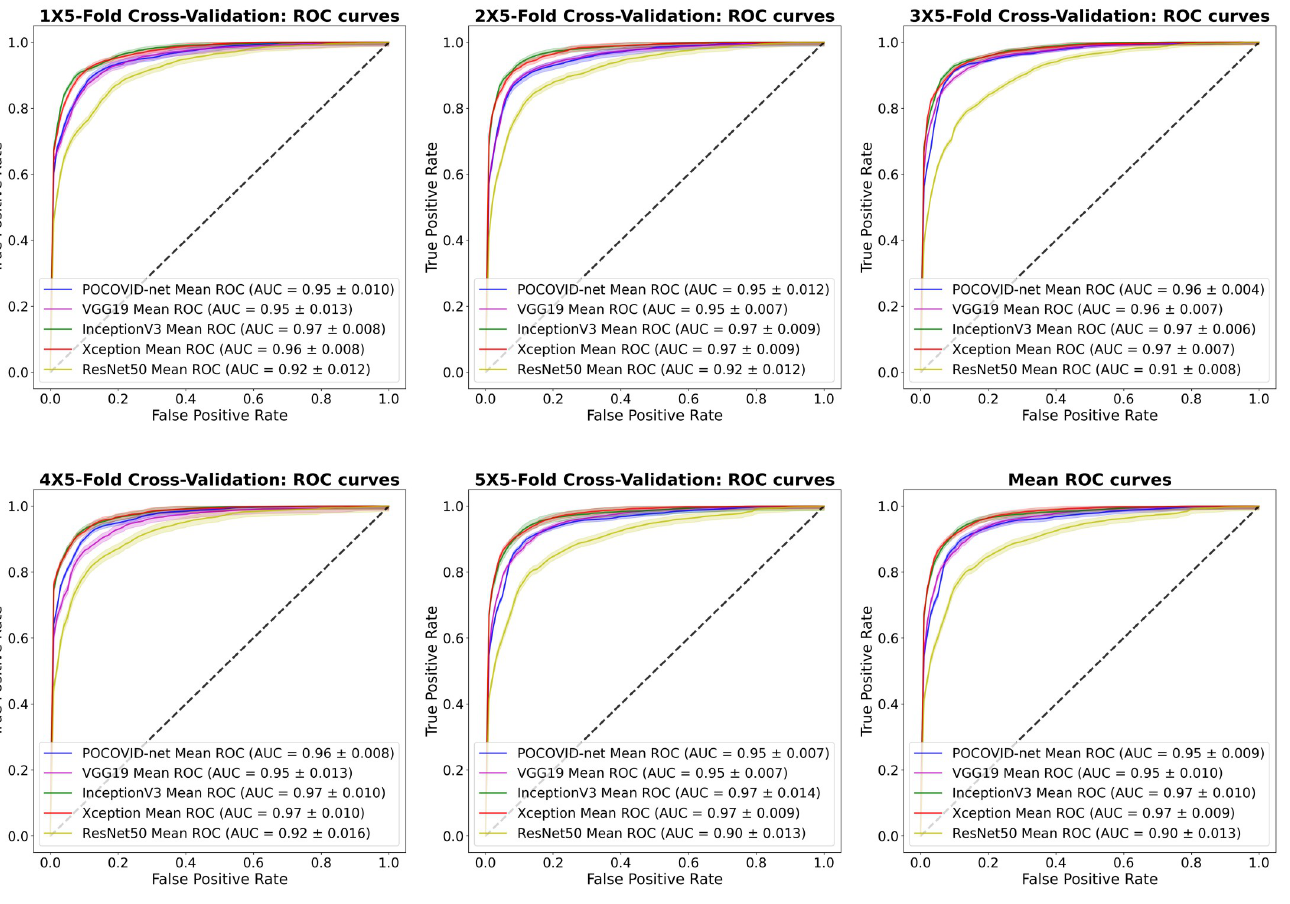
Fig 6. 5 × 5-fold cross-validation results: Mean ROC curves and AUC scores (95% C.I.).